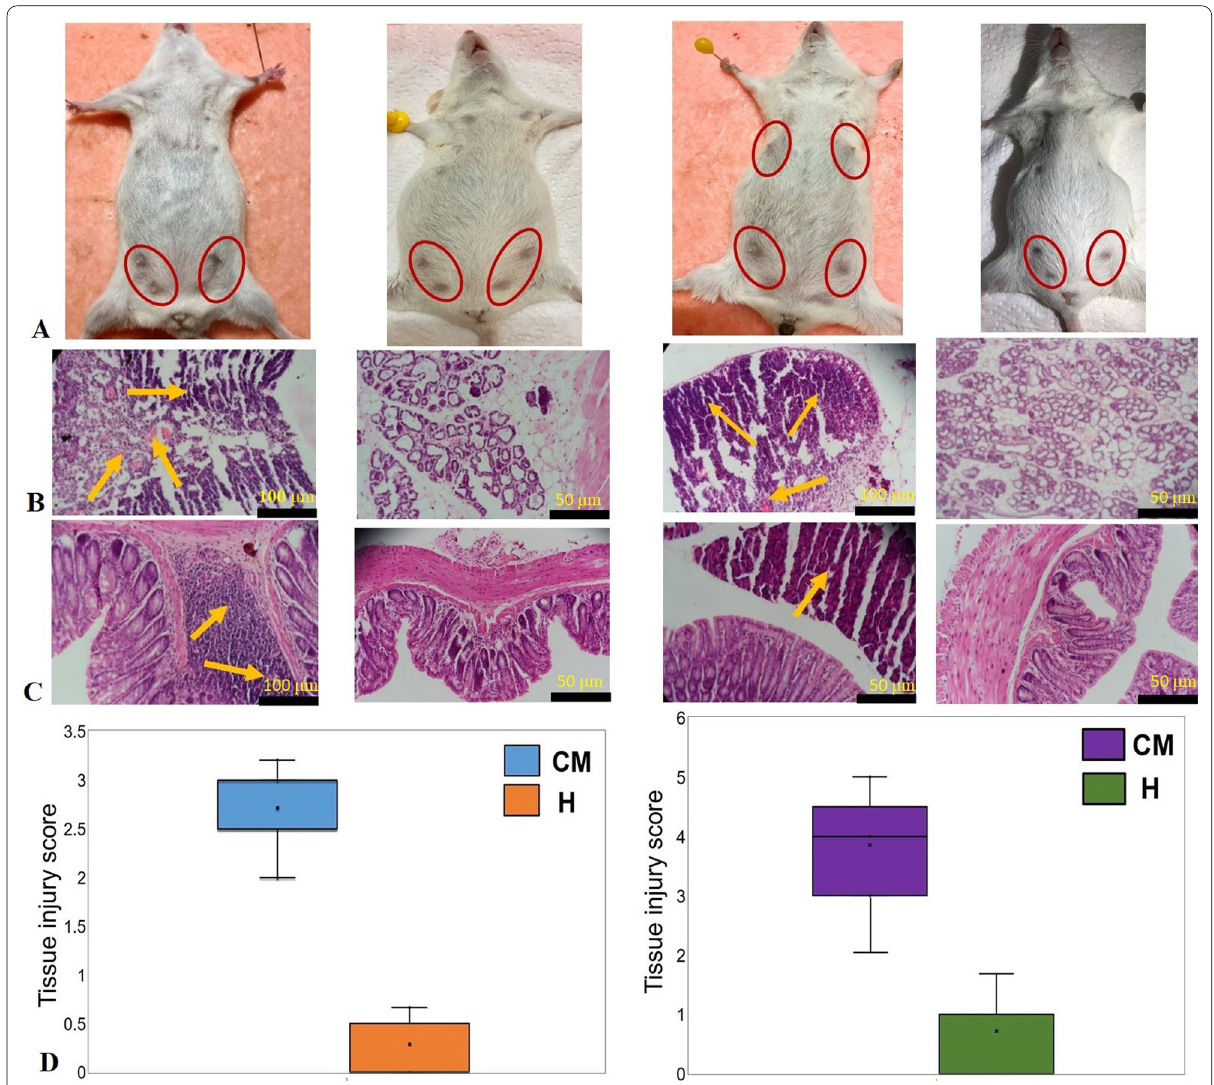
Fig. 1 Histopathological analysis of mouse gut and mammary tissues after microbiota transplantation. A Pathological changes in mammary gland surface, where different abdominal mammary glands were found as swollen and red in the mastitis (CM) group of mice on Day 27 after FMT (fecal microbiota transplantion) and MMT (milk microbiota transplantion). Mammary glands of mouse are highlighted by red circles. B Representative photomicrographs of mammary epithelial tissue after haematoxylin and eosin staining ( 100 magnification). The lesion in the mammary epithelial × cells is characterised by a central area of necrosis, broken lobules, damaged acinuses and destroyed epithelial cells, with with large numbers of inflammatory cells, predominantly neutrophils (dark bluish) and macrophages (red) (yellow arrows), in the mammary lobule, supporting connective tissue and linning of the epithelium. C Representative photomicrographs of colon (crypts, lamina propria, muscularis mucosae and submucosa) tissue after haematoxylin and eosin staining ( 100 magnification). Histopatholaogical changes in the colon tissue include moderate to severe × inflammatory cell infiltration into mucosa and submucosa, disorder in mucosal structure: epithelial necrosis, extension of the subepithelial space, and structural damage of villi (yellow arrows). Scale bars: 100 μm and 50 μm. D The tissue injury scores in the mammary gland and colon. The X-axis represents the groups of samples (CM and H) while the Y-axis denotes the injury scores as measured through Chiu Scoring System